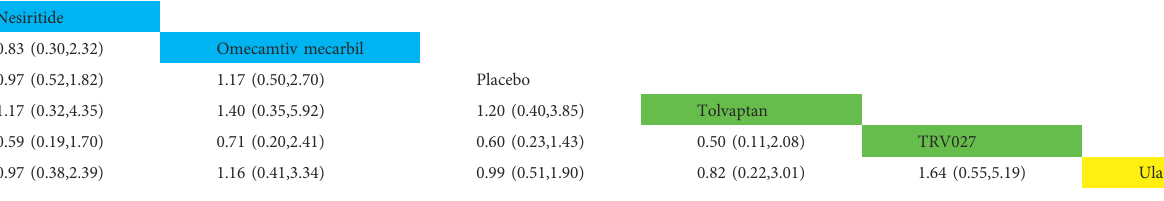
TABLE 4 Direct comparisons between different drugs of HF-related readmission rate within 30 days (reported as point estimates of odds ratios or weighted mean differences with 95% credible intervals, with number of studies contributing to network). Among them, those marked as yellow are vasodilators, those marked as blue are cardiotonics, those marked as green are vasoconstrictors, and those marked as white are placebos. Nesiritide